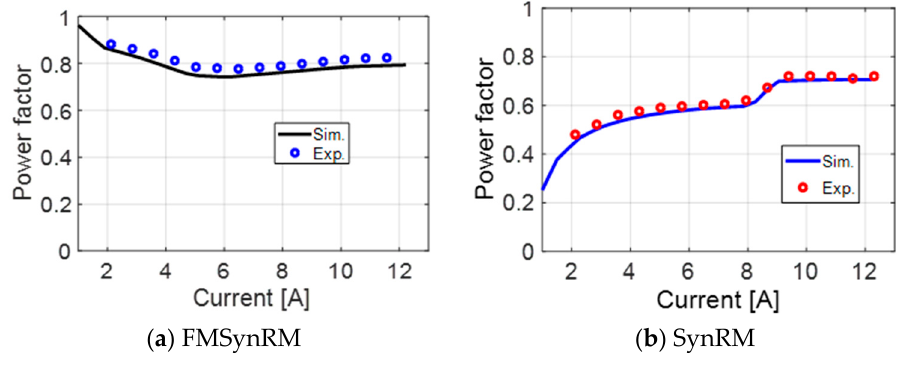
Figure 15. Measured motor power factor at different currents.